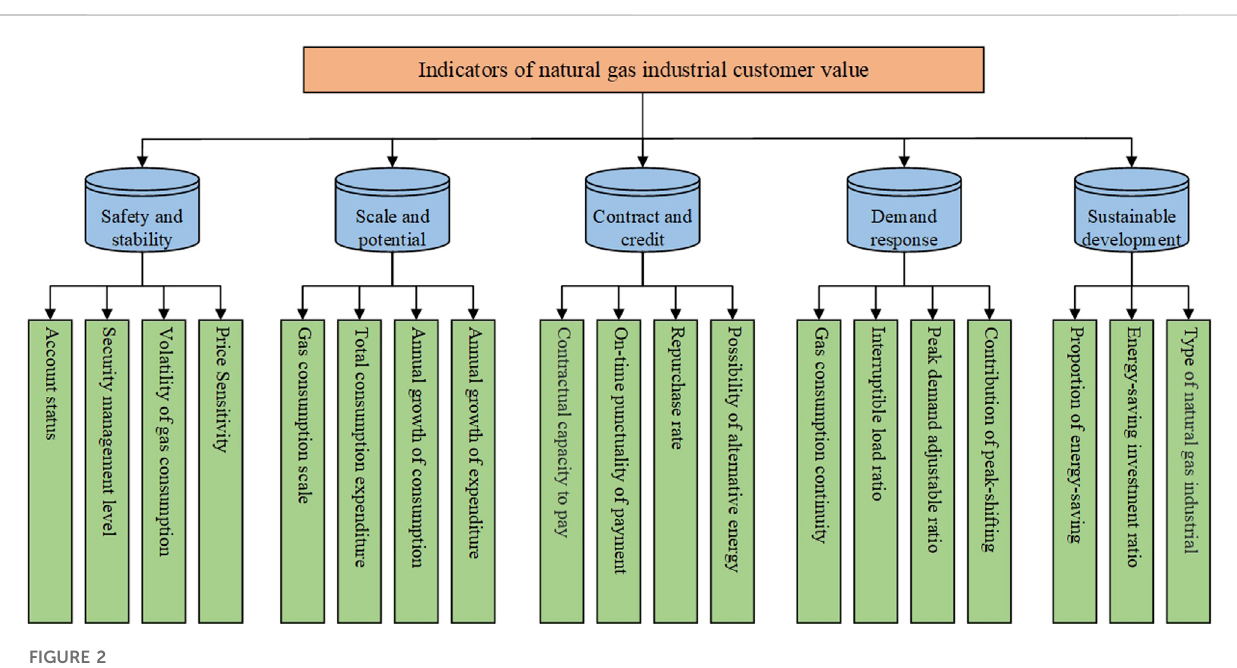
FIGURE 2 Evaluation system of natural gas industrial customer